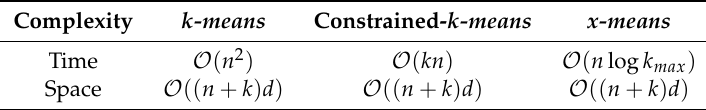
Table 6. Complexities of different variants of k-means